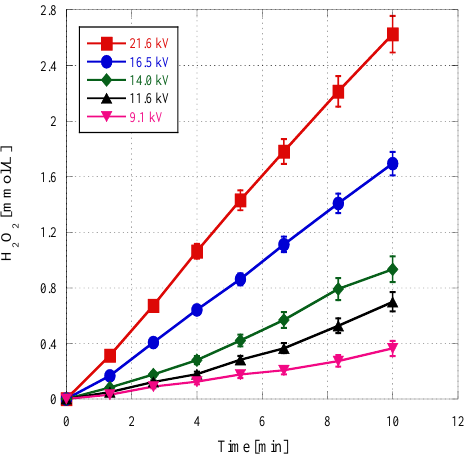
Figure 6. Production of hydrogen peroxide (H 2 O 2 ) for different voltage amplitudes of streamer discharge at water surface.